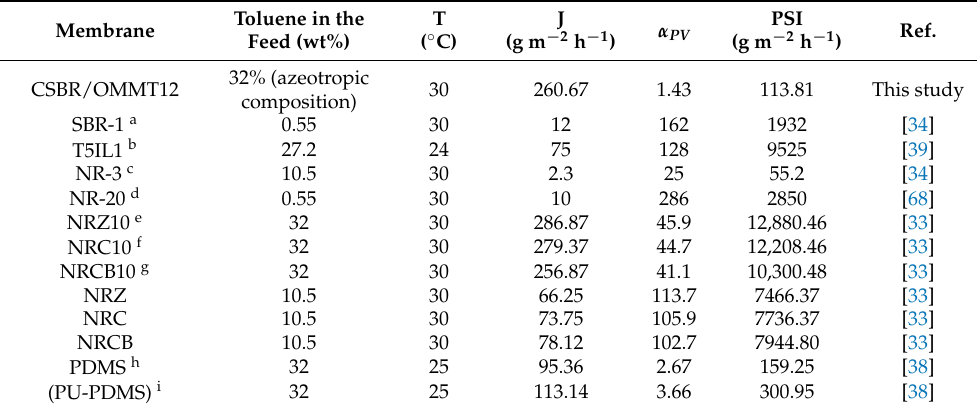
Table 8. Comparative results of the methanol/toluene mixture separation by pervaporation using different rubbery membranes taken from the literature.